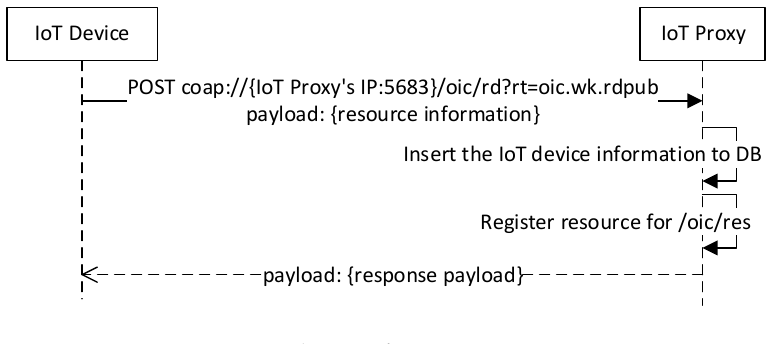
Figure 6. IoT device information registration.